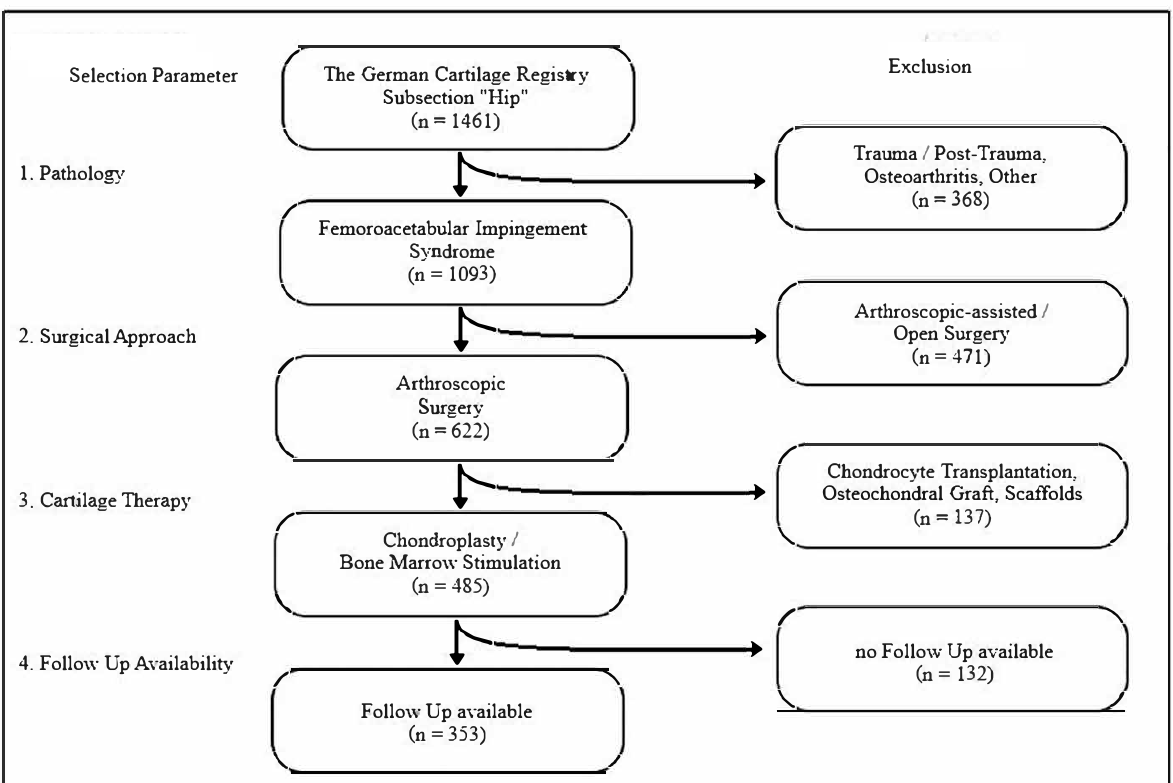
Figure 1. Patient selection procedure. Flowchart of the selection procedure based on the subsection ‘Hip’ of the German Cartilage Register (database as of August 2019). Note: “no Follow Up available” indicates an incomplete